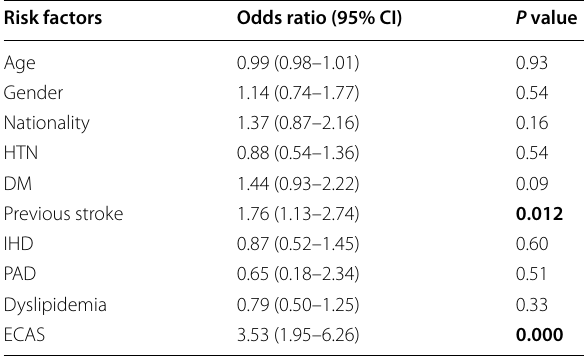
ICAS intracranial atherosclerotic stenosis, HTN hypertension, DM diabetes mellitus, TIA transient ischemic attack, IHD ischemic heart disease, PAD peripheral arterial disease, ECAS extracranial atherosclerotic stenosis